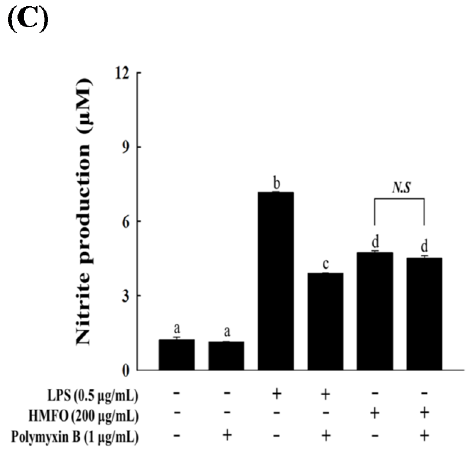
Figure 5. Effects of HMFO on NO production and iNOS expression in RAW 264.7 macrophages. RAW 264.7 macrophages were stimulated with HMFO (50, 100, or 200 µ g/mL) and LPS (1 µ g/mL) for 24 h. The production of NO ( A ) was determined by measuring nitrite accumulation in culture medium; ( B ) Total proteins were isolated from cells stimulated with HMFO (50, 100, or 200 µ g/mL) or LPS (1 µ g/mL) for 24 h. β -Actin was used as an internal loading control; ( C ) Cells were pretreated with polymyxin B (1 µ g/mL), followed by stimulation with HMFO (200 µ g/mL) or LPS (0.5 µ g/mL) for 24 h. NO production was determined by measuring nitrite accumulation in culture medium. Values with the different letters are significantly different ( p < 0.05). HMFO, polysaccharides of high-molecular-weight fraction.